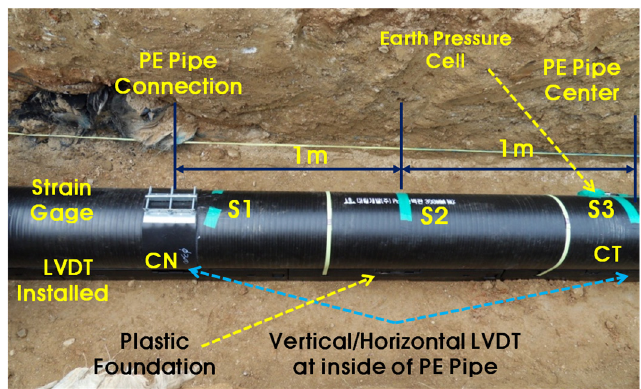
Figure 13. Measuring